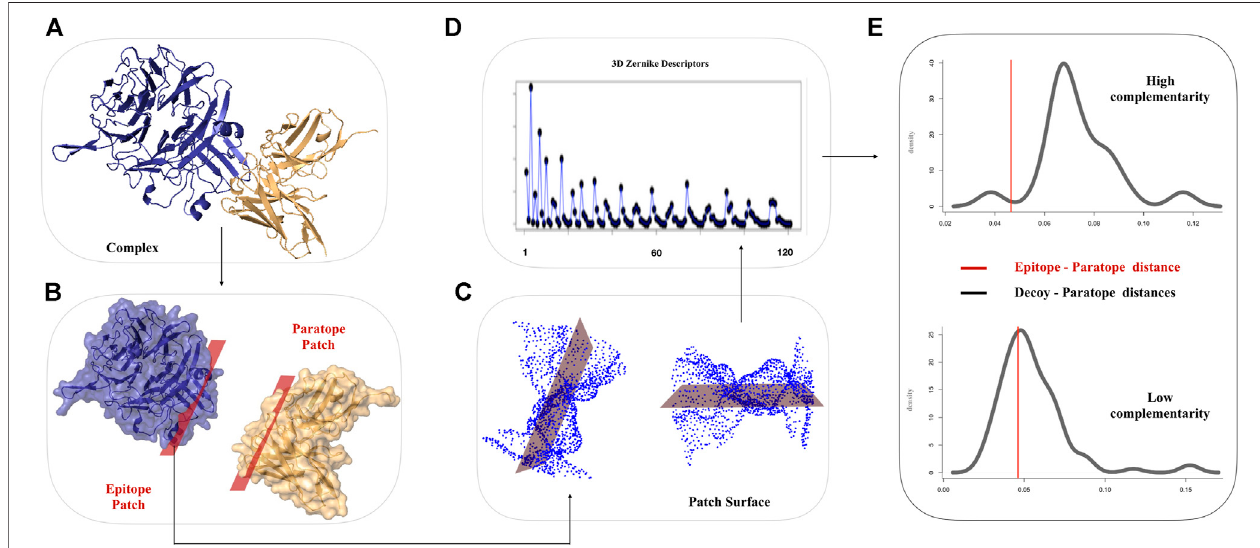
FIGURE 1 | Schematic work fl ow for the comparison of Ab-Ag interfaces based on 3DZD. (A) Molecular representation of a given Ab-Ag complex. Antibody and antigenareshowningoldandblue,respectively. (B) Theinteractingsurfacesareselectedaccordingtointer-molecularatomicdistancethreshold. (C) Solventaccessible and electrostatic surfaces are computed on the selected regions (D) 3DZD Zernike descriptors are computed for each molecular surface. (E) Distribution of 3DZD surface complementary complementarity between paratope and non-epitope surface decoys. The red line denotes 3DZD surface complementarity between the antibody paratope and their cognate